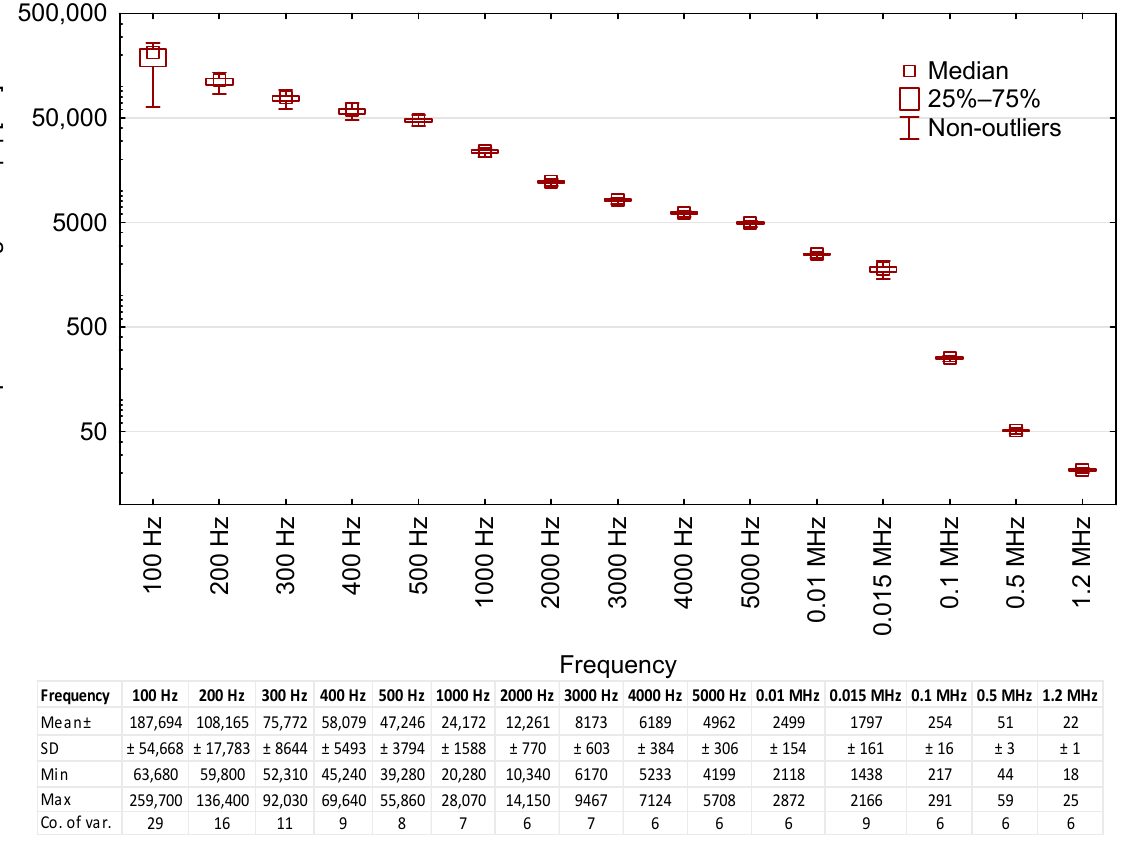
Figure 2. Impedance magnitude—| Z | readings for the tested oil samples, including base data for the results.